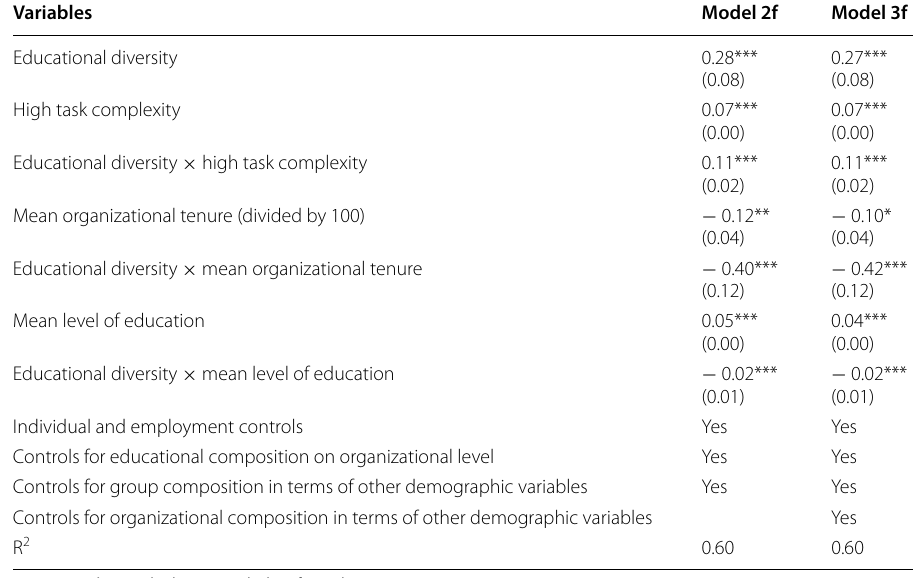
Table 4 Results for workers’ pay including controls for group and organizational